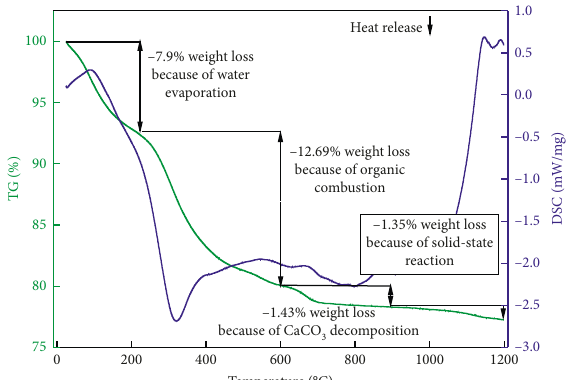
Figure 4: TG/DSC analysis of the mixture of sludge and fly